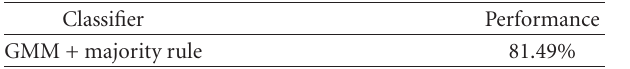
Table 9: Performance (% correct) for MFCCs. The one-second seg- ment was divided into 30-millisecond frames, and the final decision was made by combining the frame